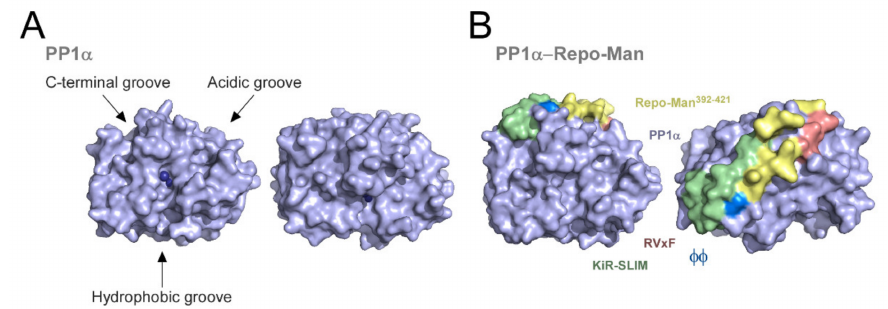
Figure 1. Structure of PP1 α catalytic subunit and its interaction with the regulatory subunit, RepoMan. ( A ) Surface representation of the three-dimensional (3D) structure of PP1 α catalytic subunit. Manganese atoms in the active site are represented as dark blue spheres and lie at the Y-shaped intersection of the three substrate-binding grooves. Protein Data Bank (PDB) accession identification (ID) for the structure: 4MOV. ( B ) Surface representation of the three-dimensional structure of the PP1 α catalytic subunit in complex with Repo-Man 392–421 . The PP1 α catalytic subunit is represented in light blue and the Repo-Man 392–421 peptide is represented in yellow. The interaction is mediated by RVxF (red), ΦΦ (blue) and KiR-SLiM (green) motifs on Repo-Man 392–421 that bind to specific pockets on the PP1 α surface. PDB accession ID